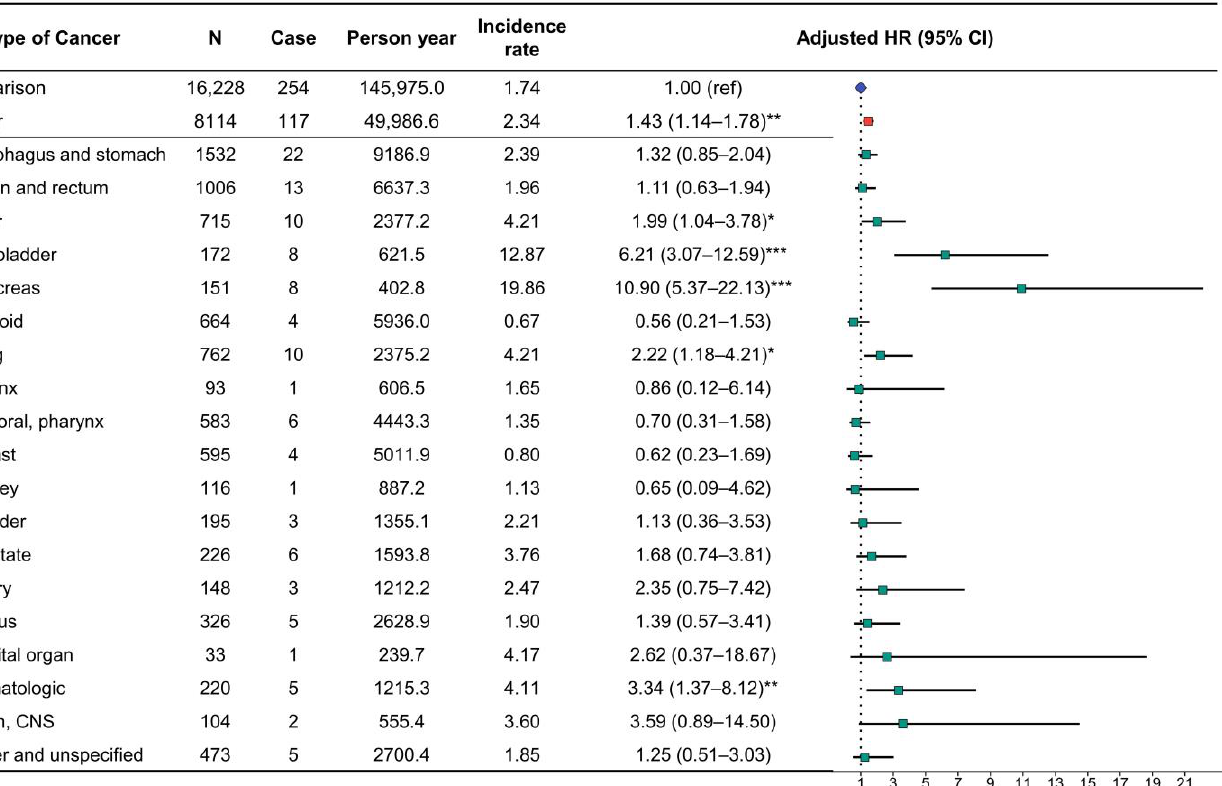
Figure 3. Incidence rate and adjusted hazard ratio for cases requiring insulin treatment in patients with type 2 diabetes by cancer type. * p < 0.05, ** p < 0.010, and *** p < 0.001.